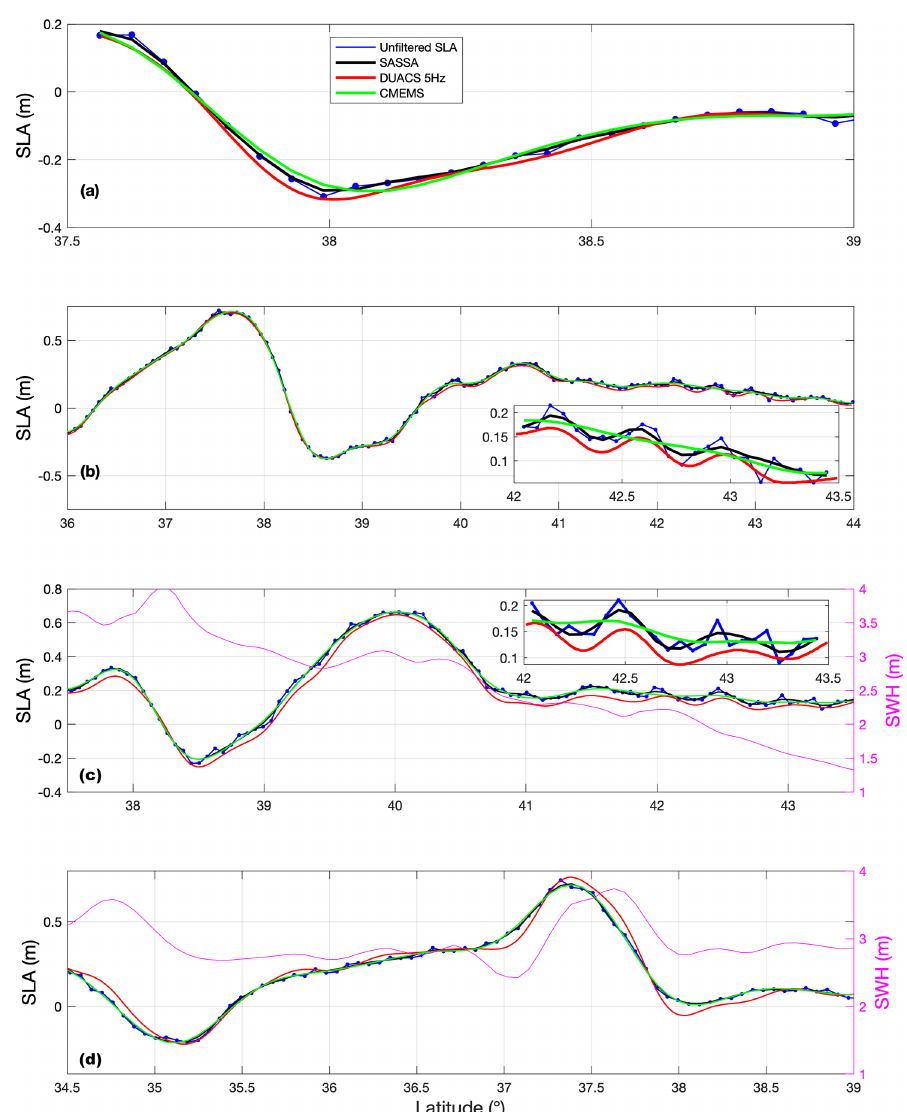
Figure 11. CMEMS unfiltered (dotted blue), SASSA (black), DUACS 5Hz (red), and CMEMS filtered (green) SLAs (m) for different AltiKa passes: (a) cycle 106 pass 597, (b) cycle 101 pass 184, (c) cycle 102 pass 941, and (d) cycle 103 pass 655. The magenta curve on the right axis in panels (c) and (d) shows the SWH from the Sea State Climate Change Initiative